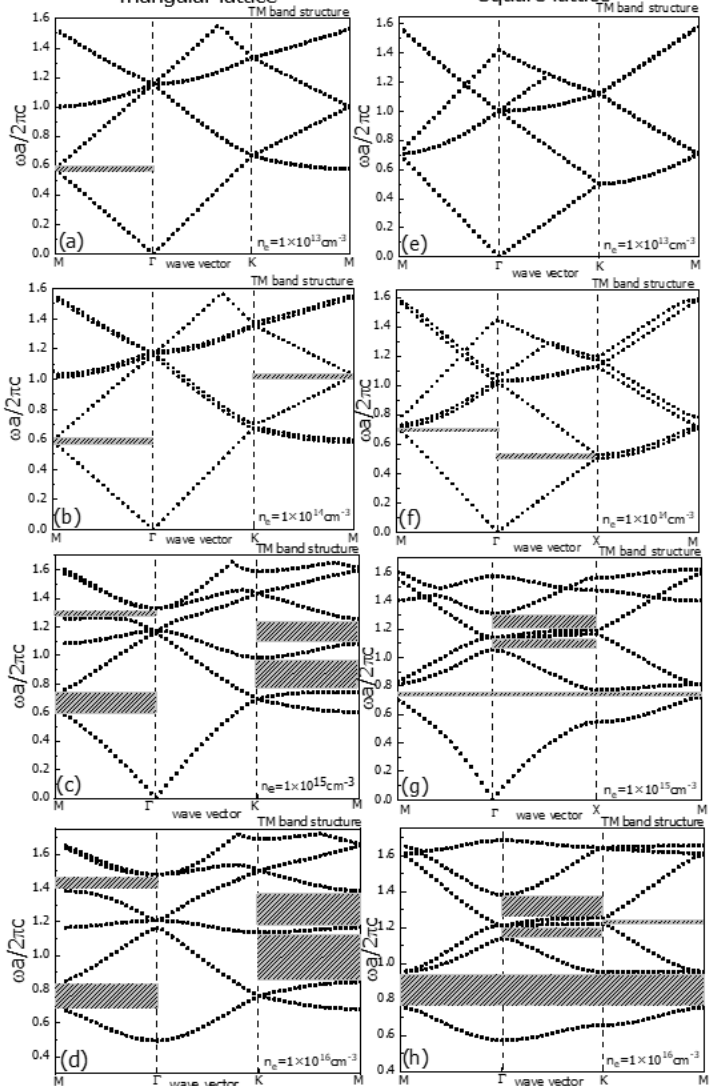
Figure 4. The dispersion relations under di ff erent electron densities for the triangular lattice ( a – d ) and the square lattice ( e – h ) shown in Figure 2a,b. The shadow strips indicate the positions of the band gaps. The plasma collision frequency υ m = 160 GHz.